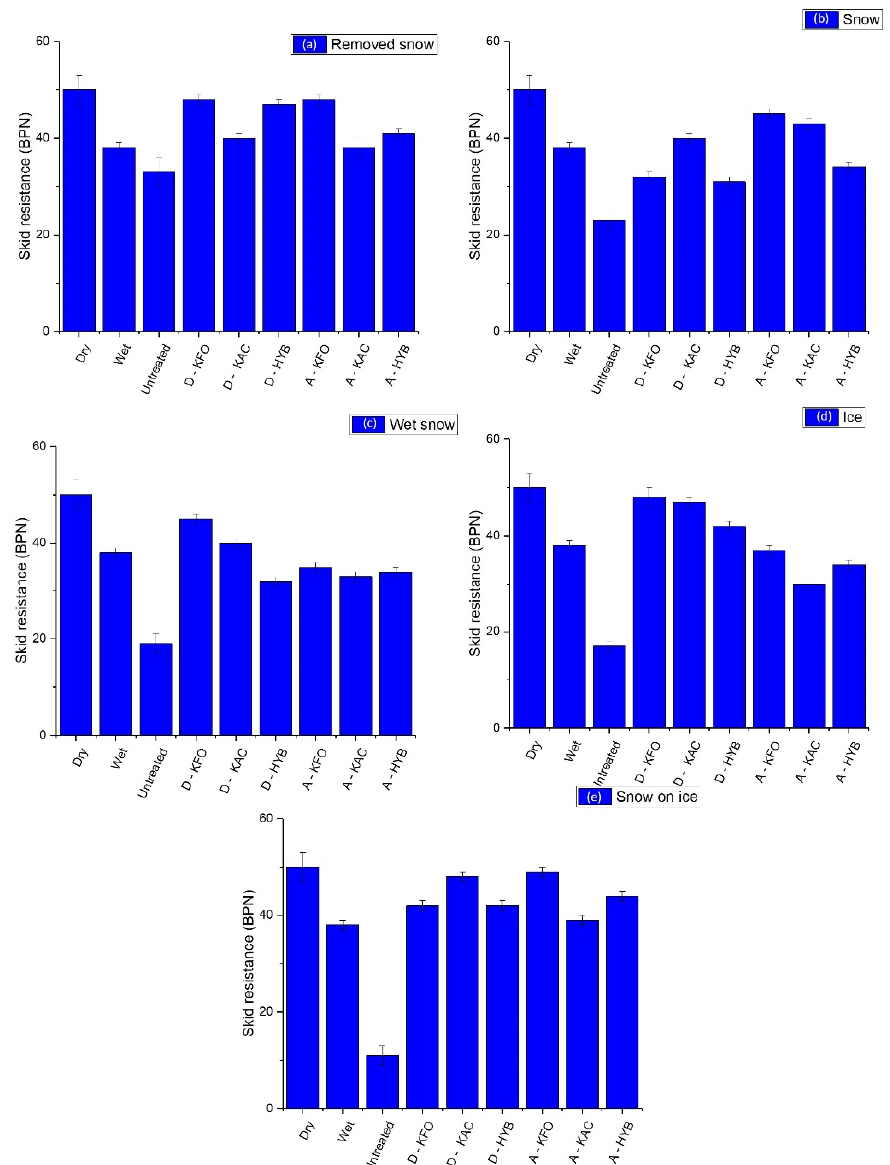
Figure 7. Skid resistance of different RDPs used in de-icing mode (D) and anti-icing mode (A) under various icing conditions ( a ) Removed snow ( b ) snow ( c ) wet snow ( d ) ice and ( e ) snow on ice.